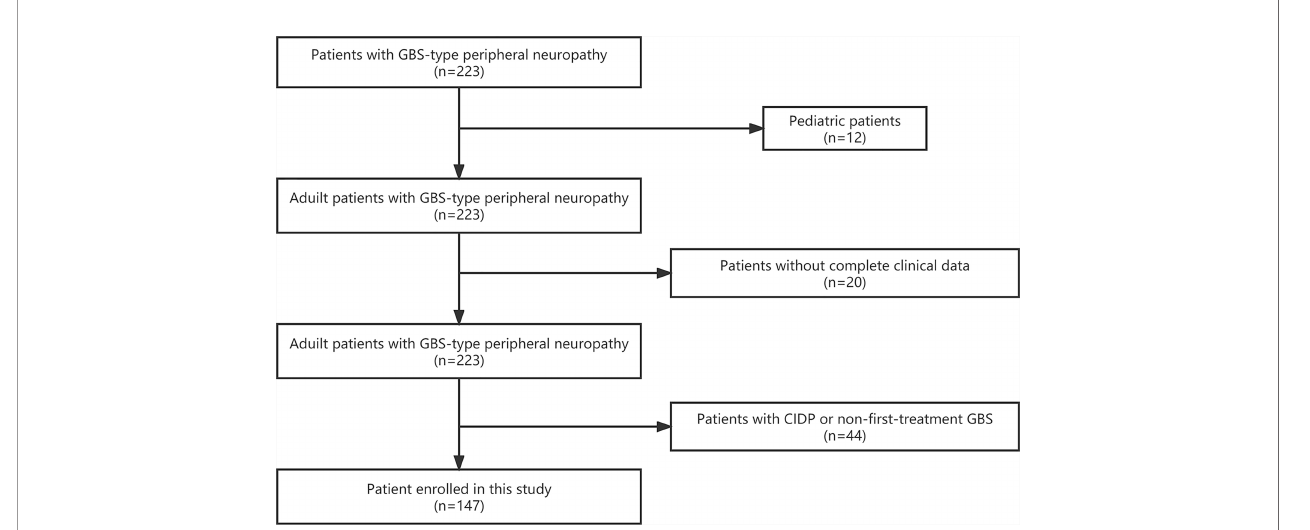
FIGURE 1 | Flow diagram of the study